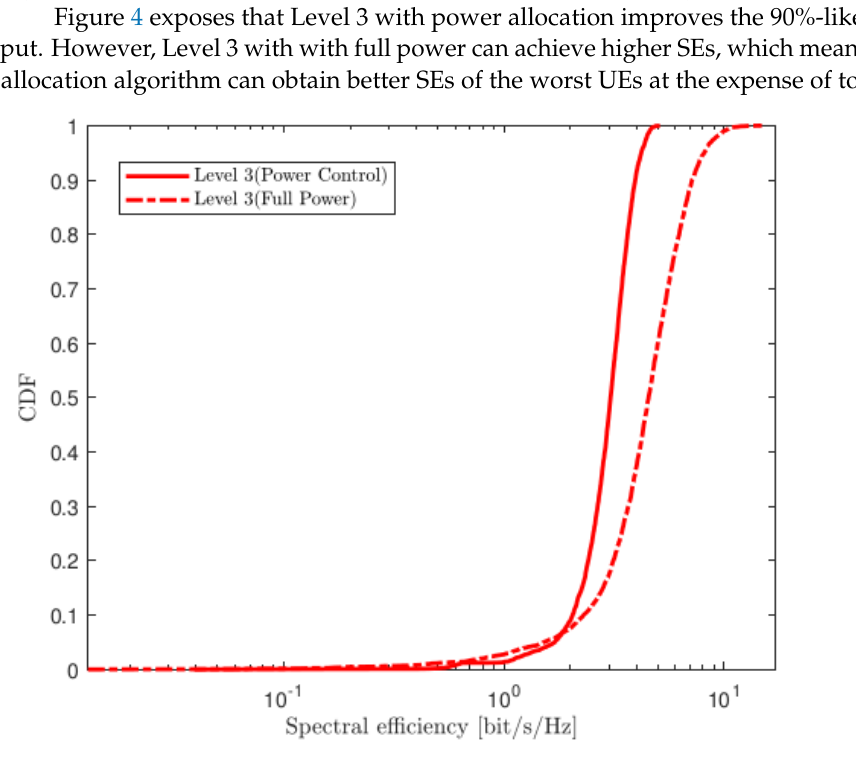
Figure 4. In the case that partial APs serve the UEs, the SE comparison of Level 3 between full power and power